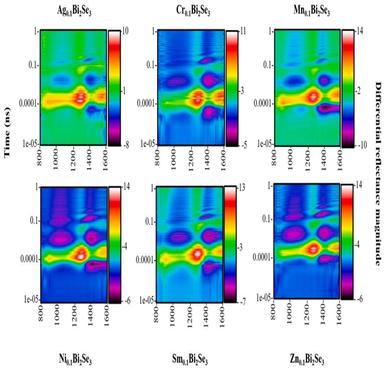
The 2D contour plot of differential reflectance (ΔR) magnitude with respect to probe wavelength at the X-axis and probe delay at the Y-axis. The colour mapping represents the magnitude of these (ΔR).